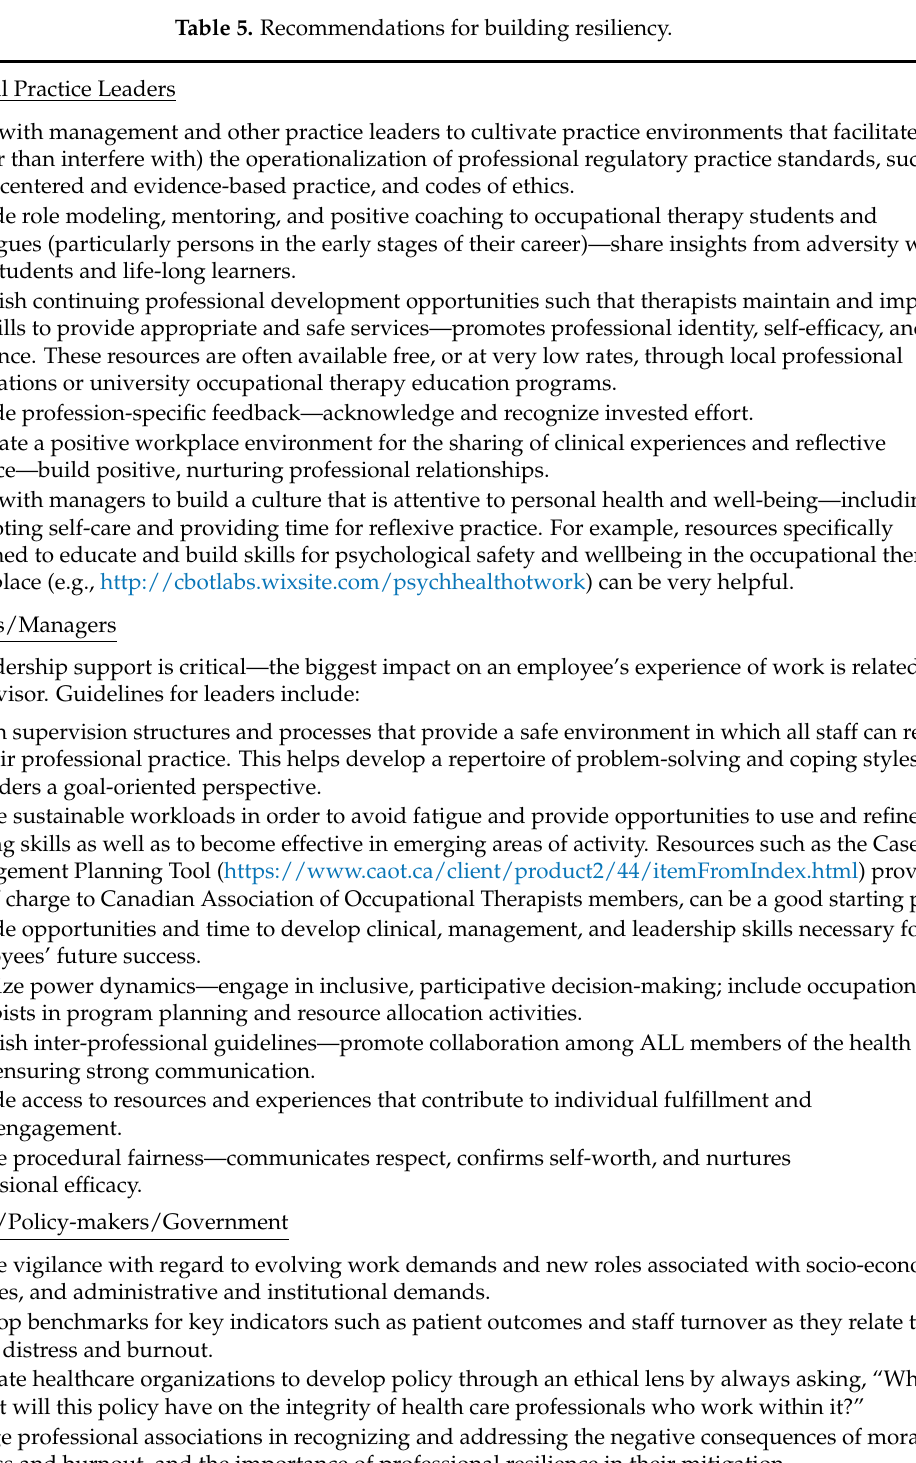
Table 5. Recommendations for building